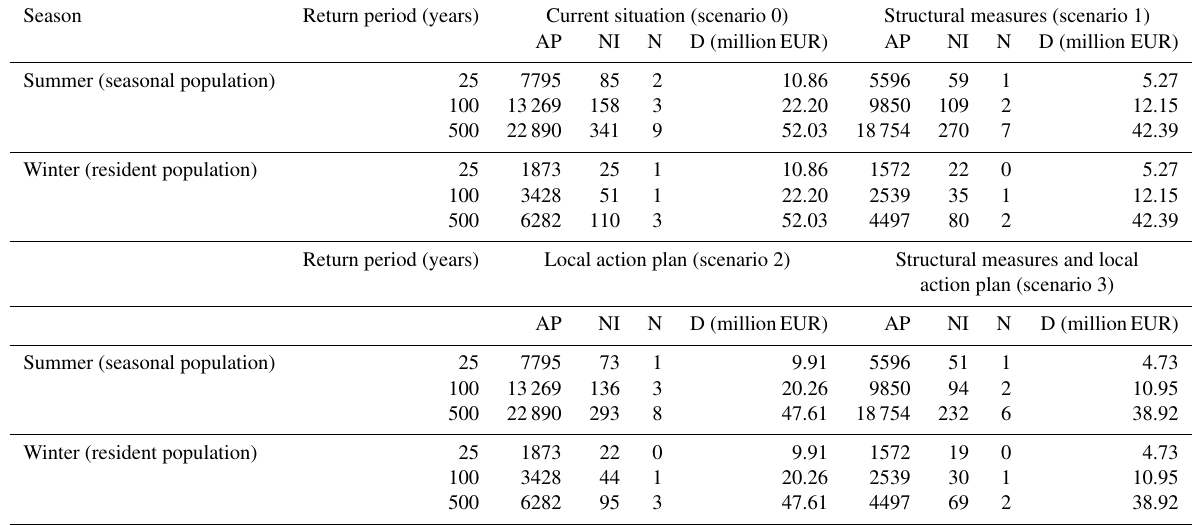
Table 5. Estimated impact per scenario and flood event.